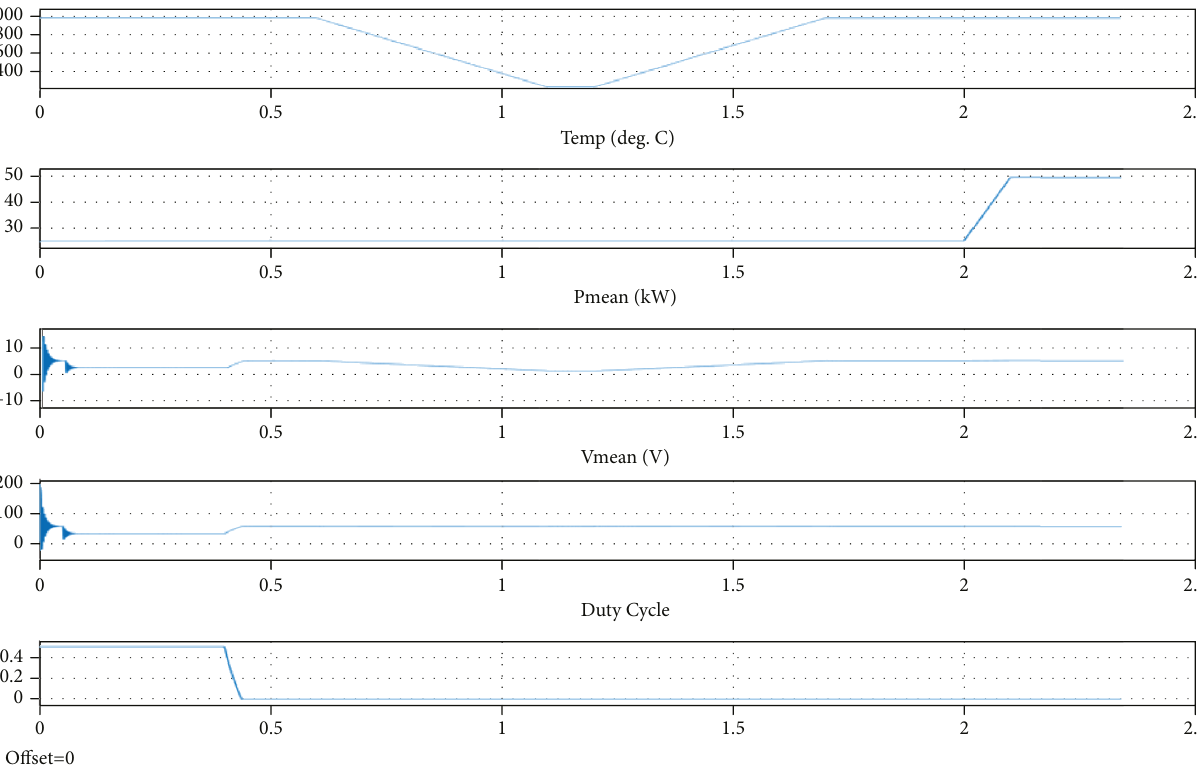
Figure 18: Solar irradiance, temperature, and generated power.